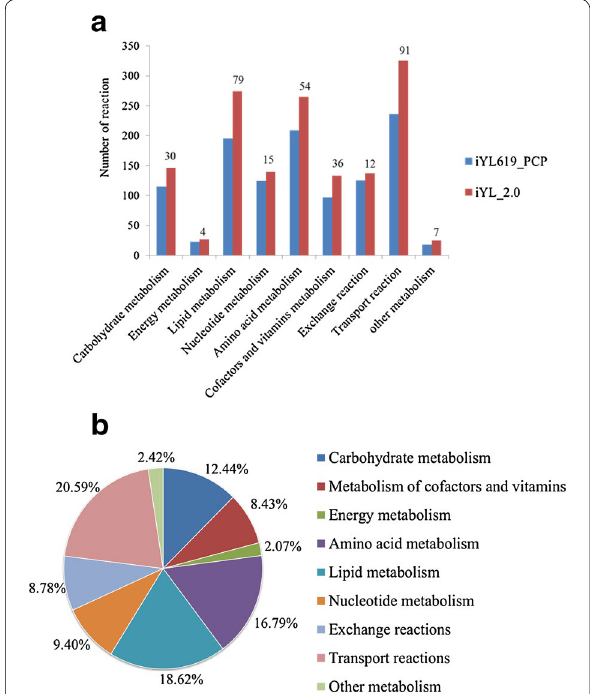
Fig. 1 Properties of the metabolic models. a Comparison of meta- bolic reactions between models iYL_2.0 and iYL619_PCP. b Metabolic subsystems distribution in genome-scale metabolic model iYL_2.0